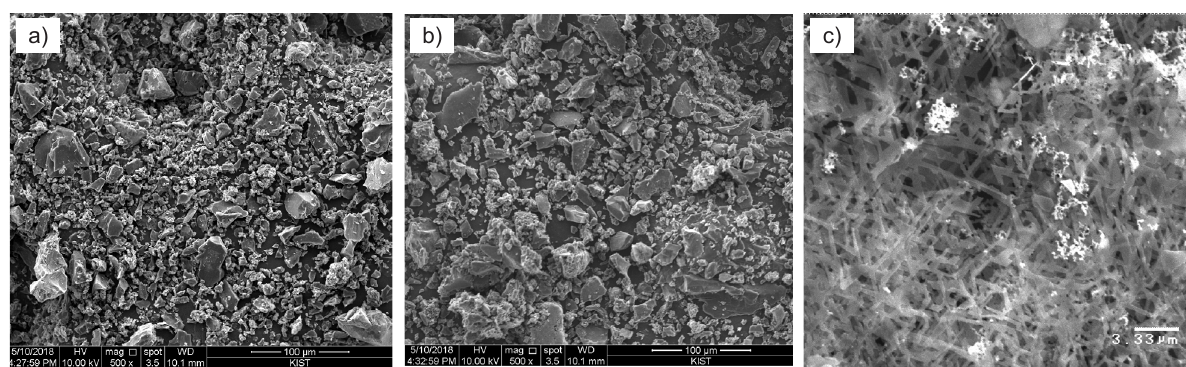
Fig. 3. SEM images of a) primary activated carbon, b) AC treated under supercritical water condition, and c) AC-Ag nanocomposite.